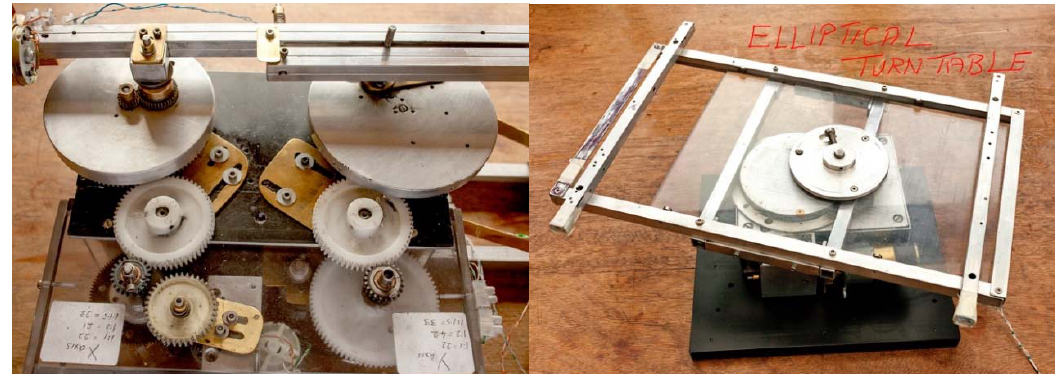
Figure 4. X:Y configuration, sun and planet on the left, elliptical turntable.